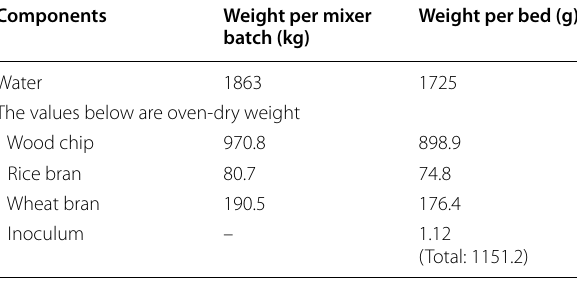
Table 4 Weight composition of the cultivation bed Components